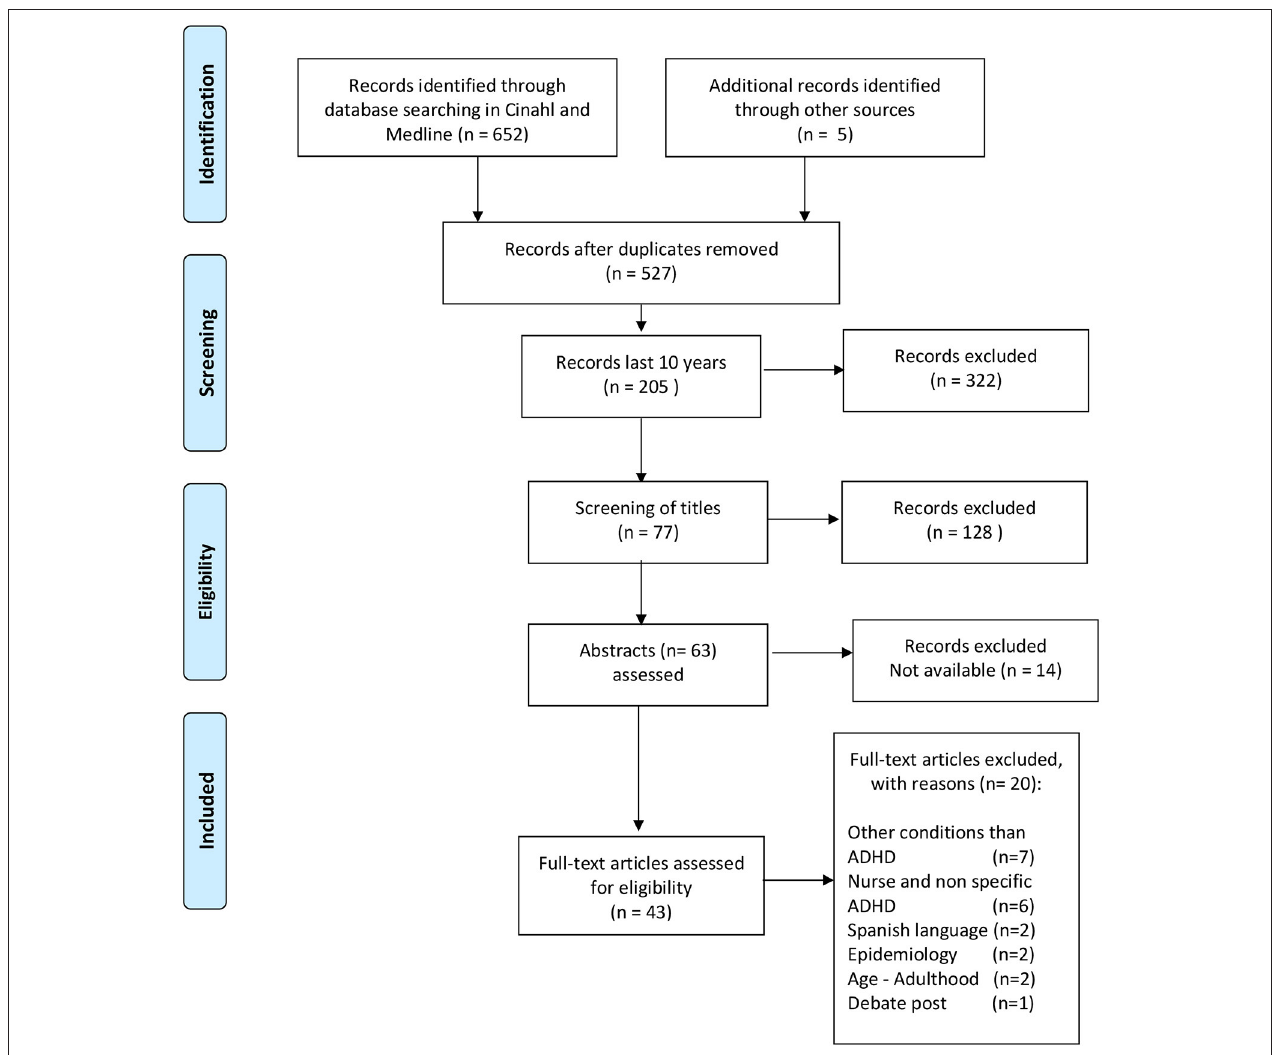
FIGURE 1 | Review of ADHD–Nurse–Child and